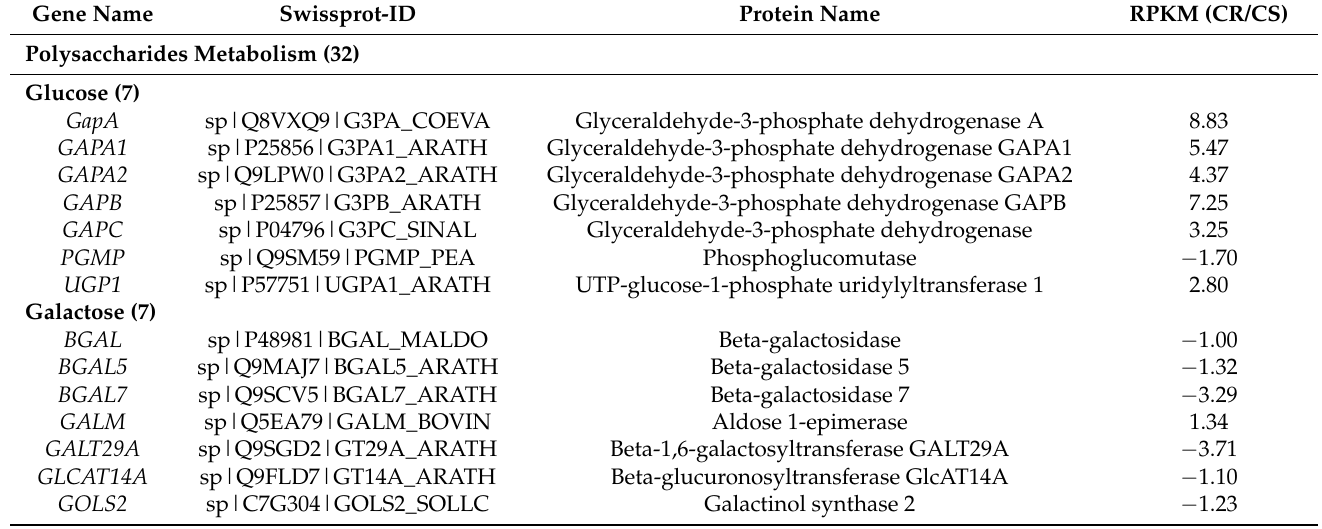
Table 1. DEGs involved in carbohydrate metabolism and transport in the CR compared with